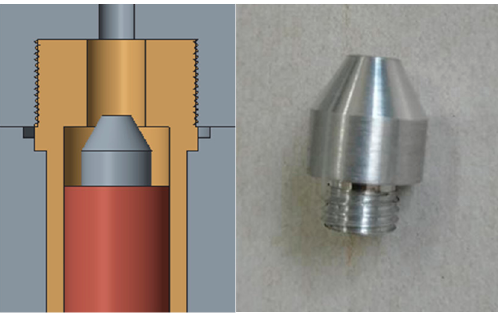
Figure 6. Seat buffer block.